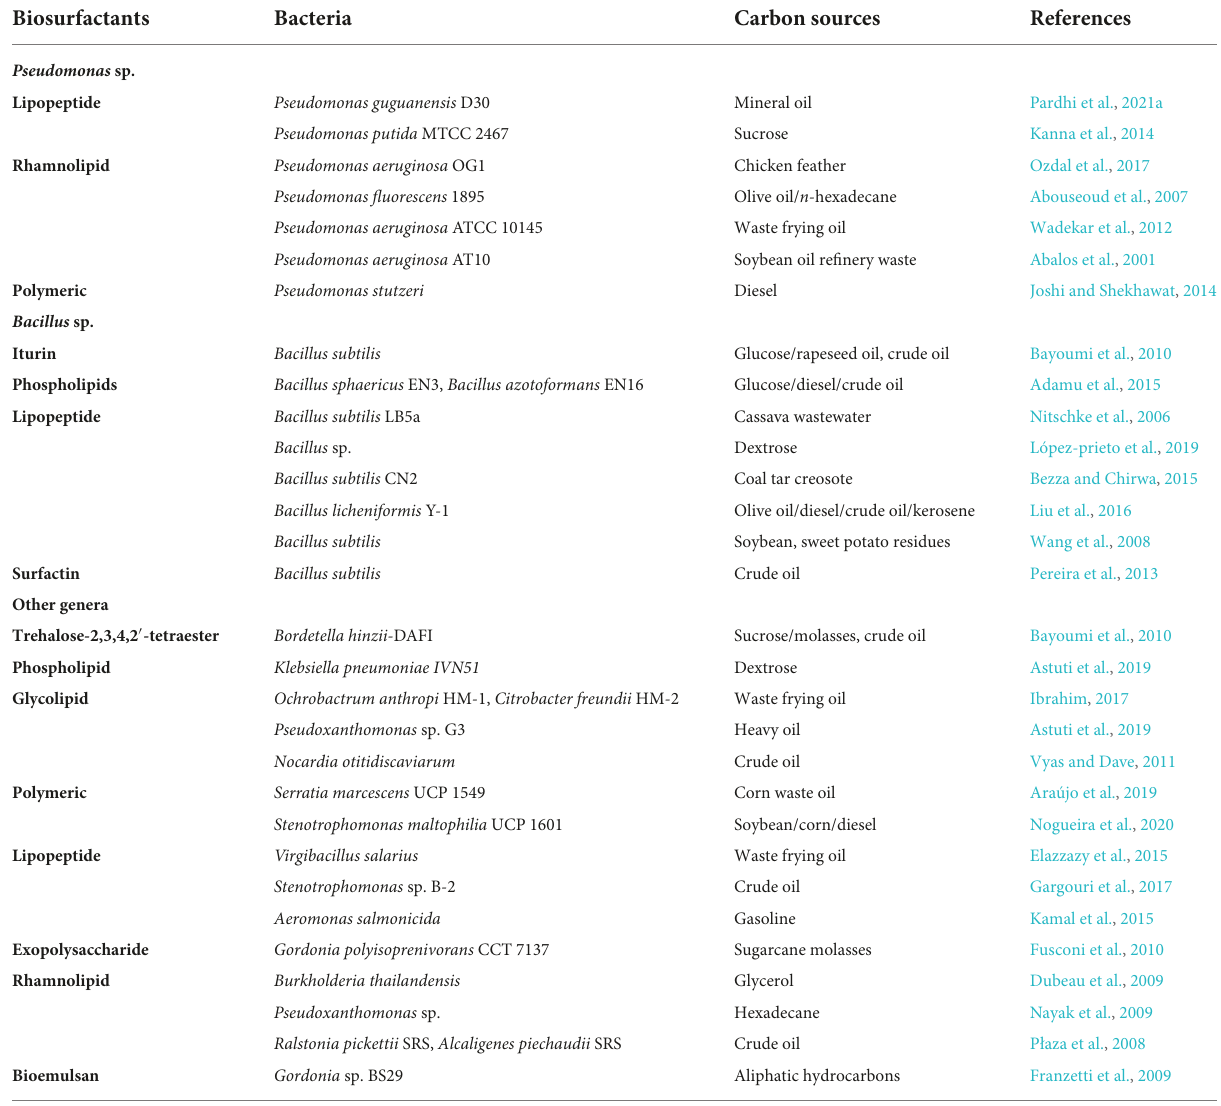
TABLE 1 Bacterial strains producing